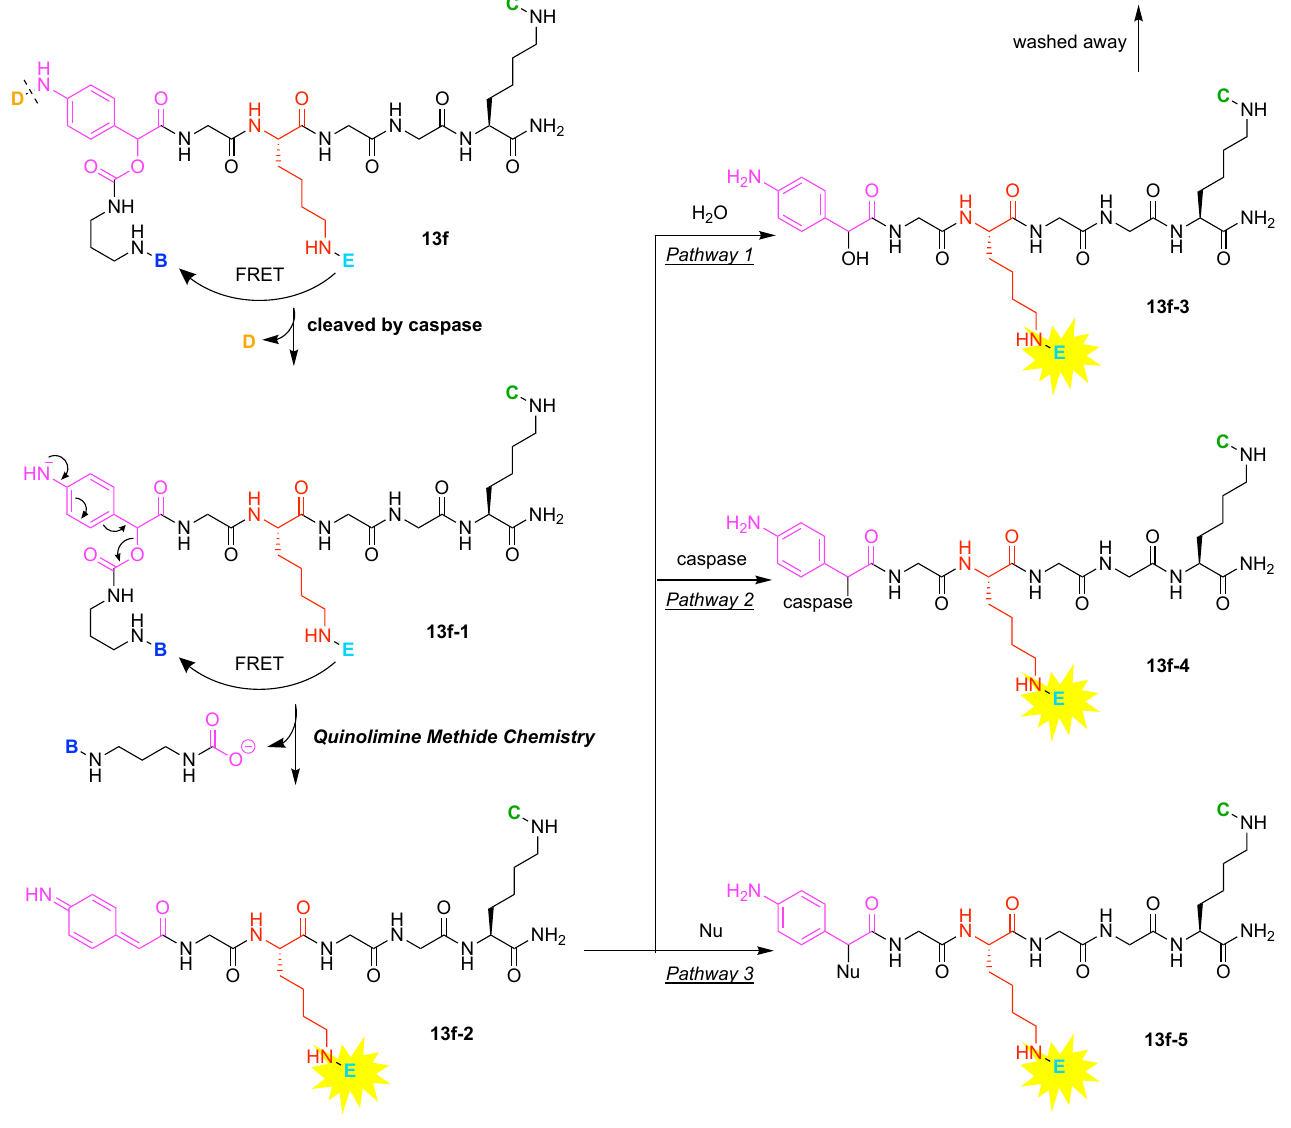
Figure 66. Enzymatic activation of the qABP in this study via quinolimine methide chemistry, and possible subsequent reactions in an intracellular environment.